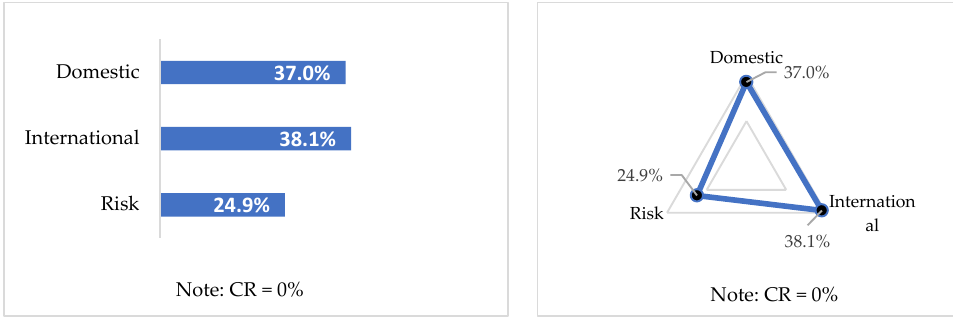
Figure 3. Local weights for level 2.